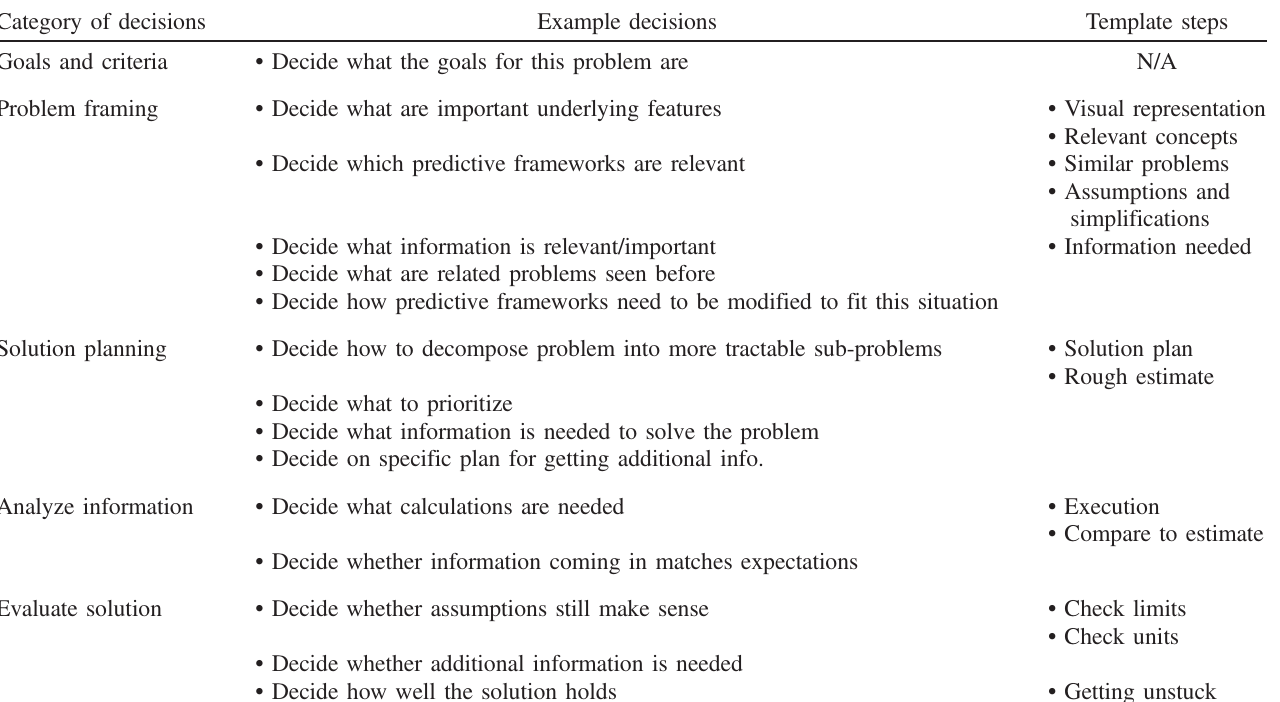
TABLE I. Correspondence between categories of decision making identified by Price et al. , specific expert decisions falling into those categories, and relevant steps in the